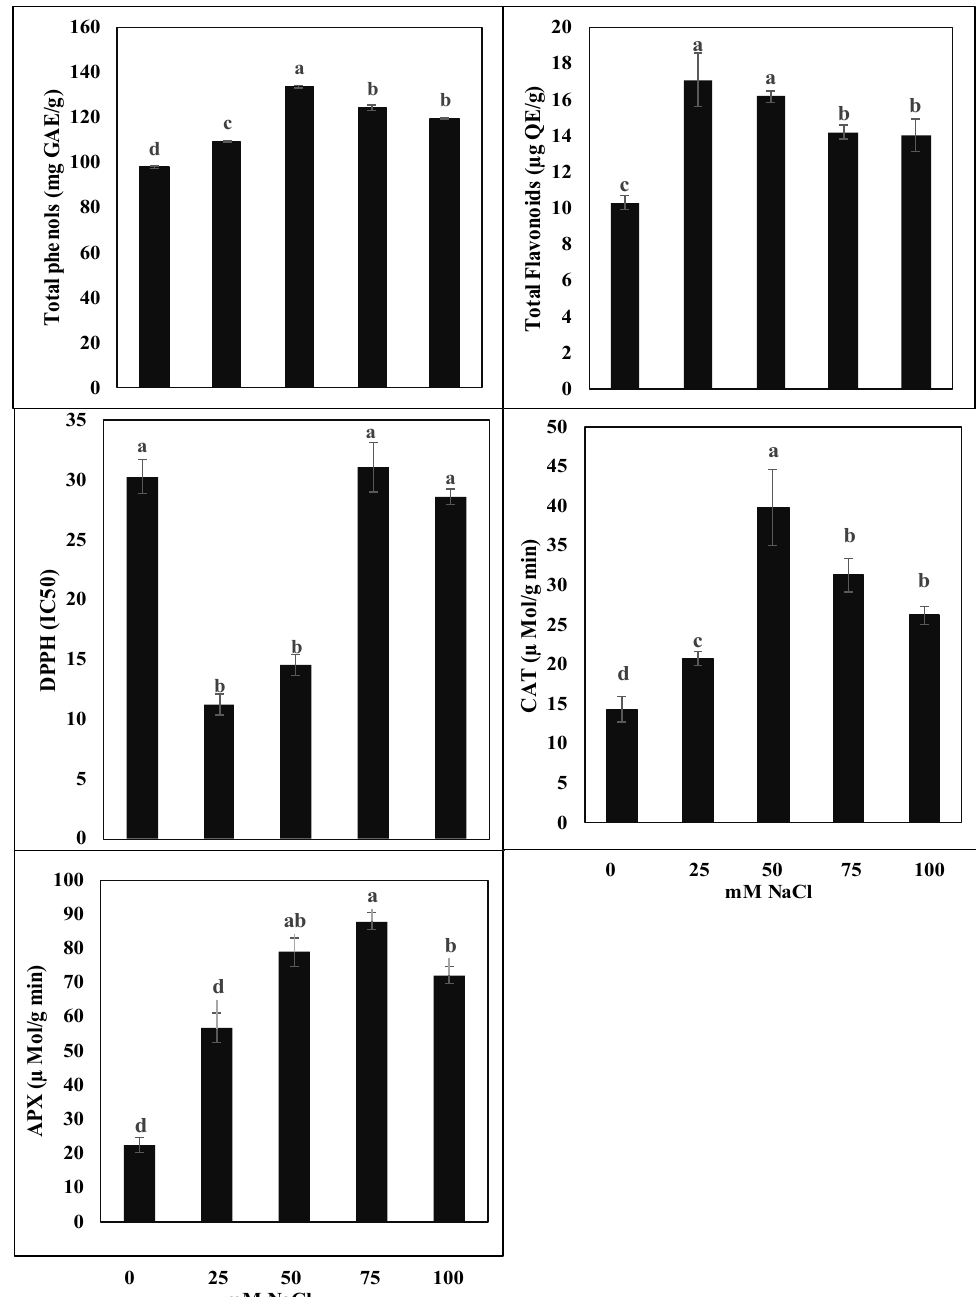
Figure 2. The effect of salinity stress on physiological and biochemical parameters measured in vitro. Means along with the same letter are not significantly different at 5% significance level ( p ≤ 0.05).